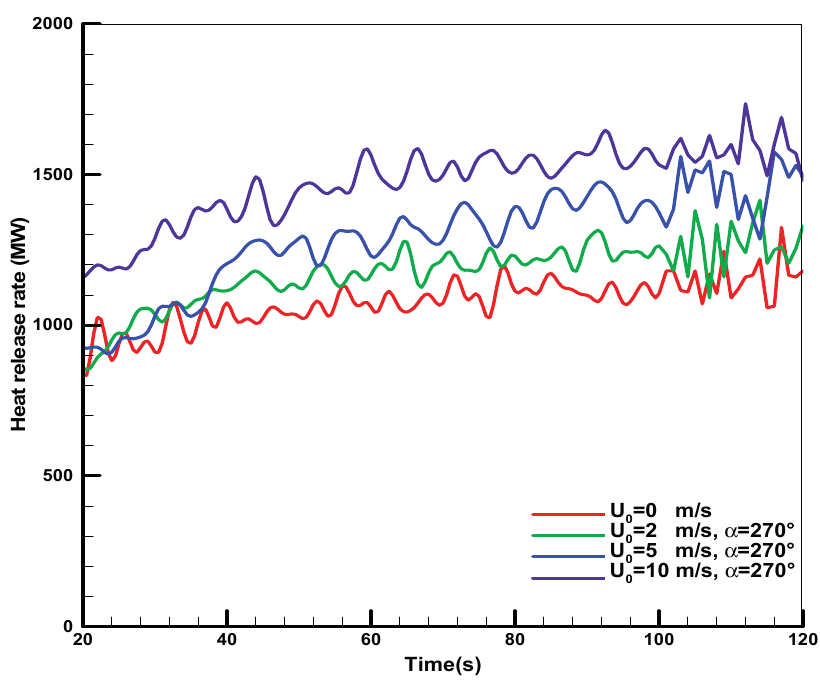
Figure 21. History of the heat release rate during the fire propagation over the composite-type aircraft for the different wind